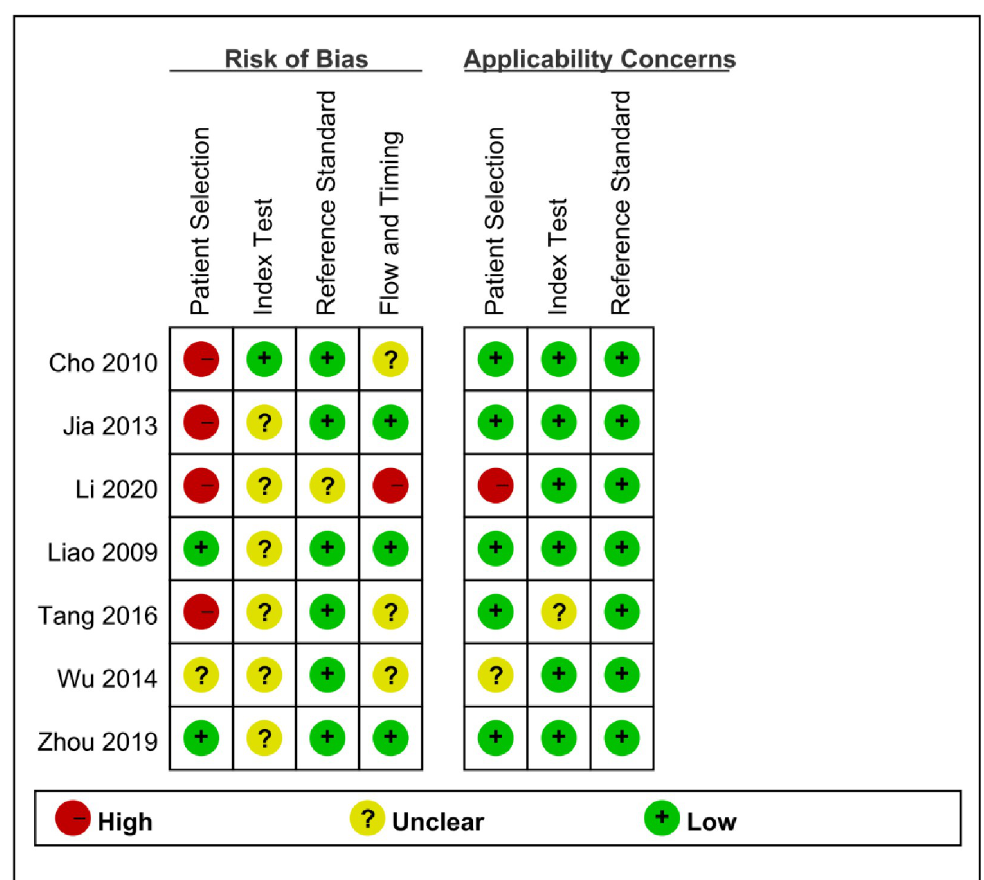
Fig 2. Risk of bias assessment of the included studies. According to the QUADAS-2 (Quality Assessment of Diagnostic Accuracy Studies-2), the summary of the methodological quality of studies.